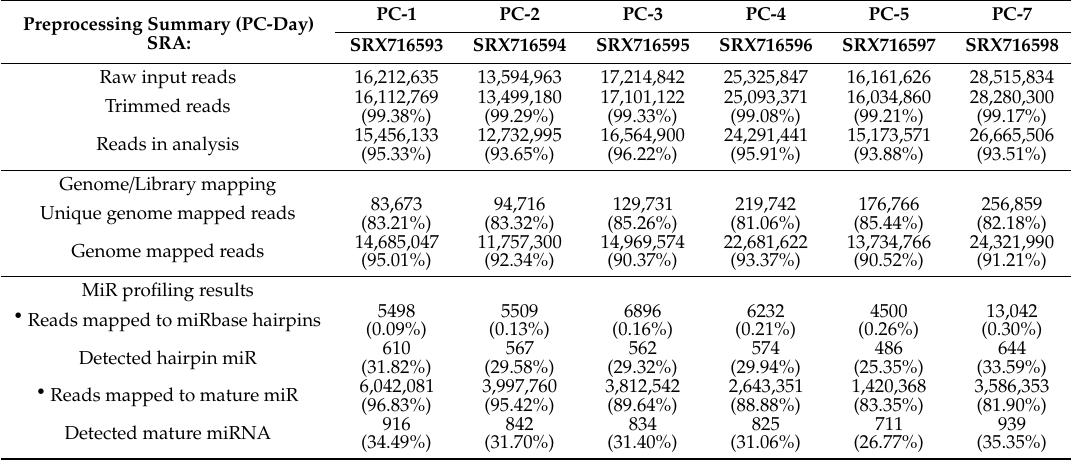
Table 1. A summary of microRNA (miRNA) analysis in platelet